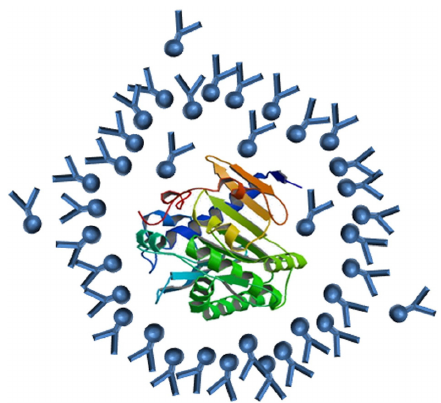
Figure 4. Model arrangement of the protein molecule within a water pool, with propanol molecules forming the interface between hexane and water [124]. Reprinted from Curr. Opin. Colloid Interface Sci. , 22 , Xenakis, A.; Zoumpanioti, M.; Stamatis, H., Enzymatic reactions in structured surfactant ‐ free